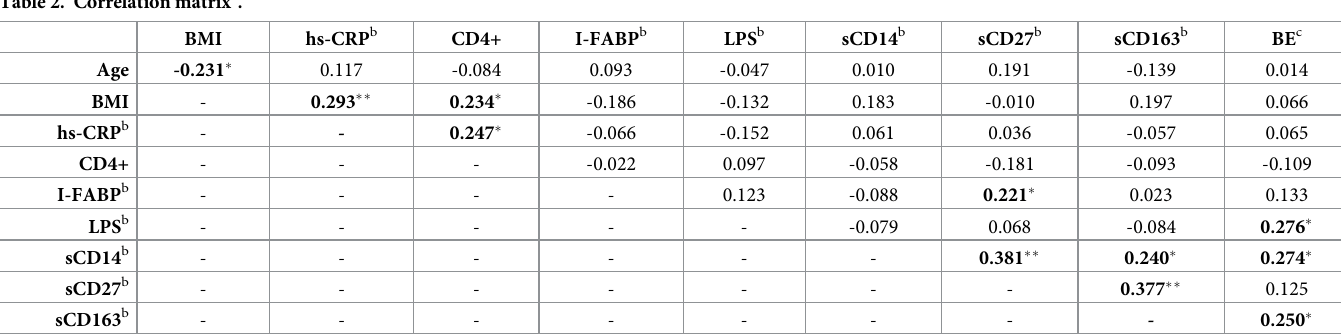
Table 2. Correlation matrix a